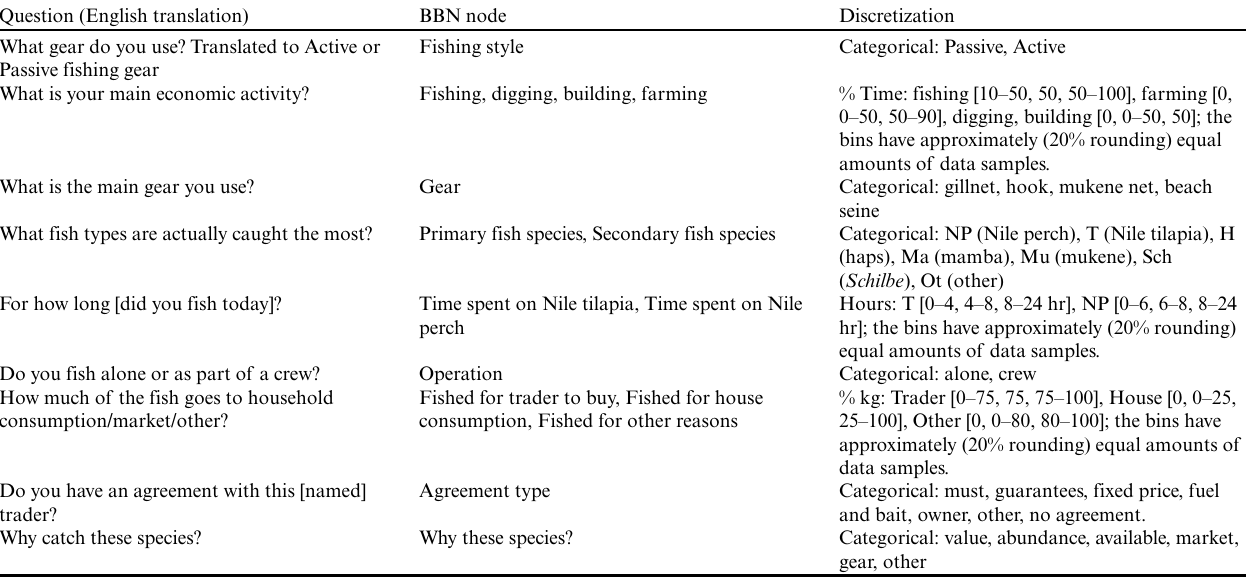
Table 1 . Fisher’s questions used for the Bayesian Belief Network (BBN) and the discretization of the answers.